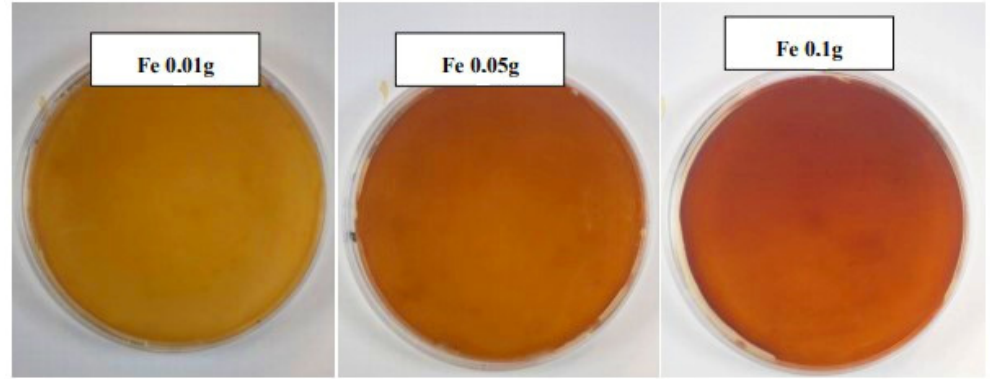
Figure 1. Color changes in Metschnikowia pulcherrima 147. Indicated amounts of ferric-ions were added to the media, which are accompanied by the media color change.